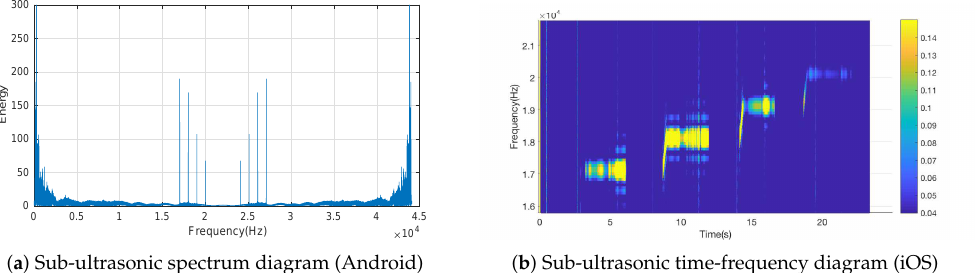
Figure 5. Identification of smartphone-based sub-ultrasonic frequency after Fourier